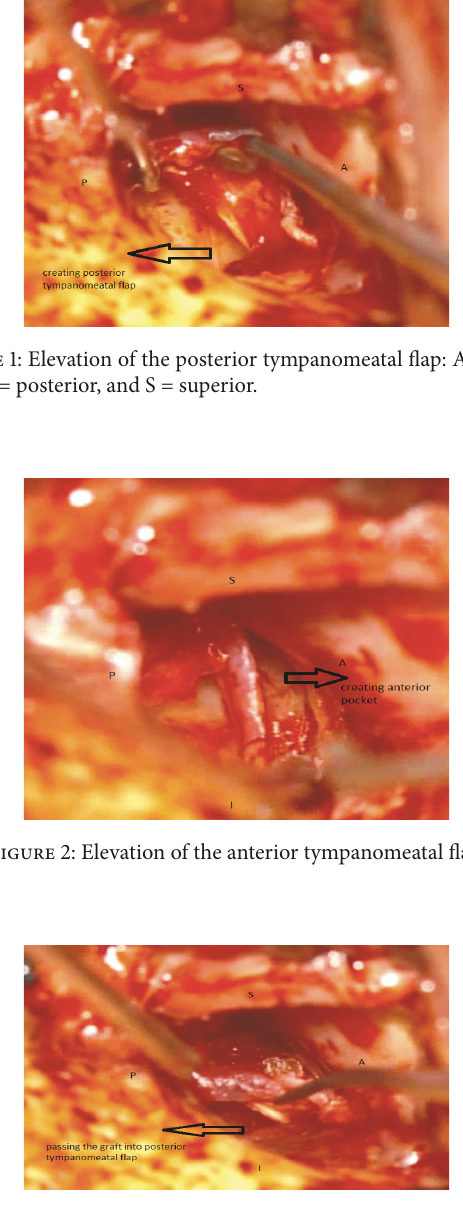
Figure 3: Passing the graft into posterior tympanomeatal flap.